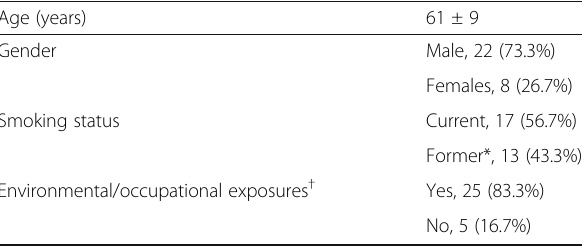
Table 1 Demographic data of the studied